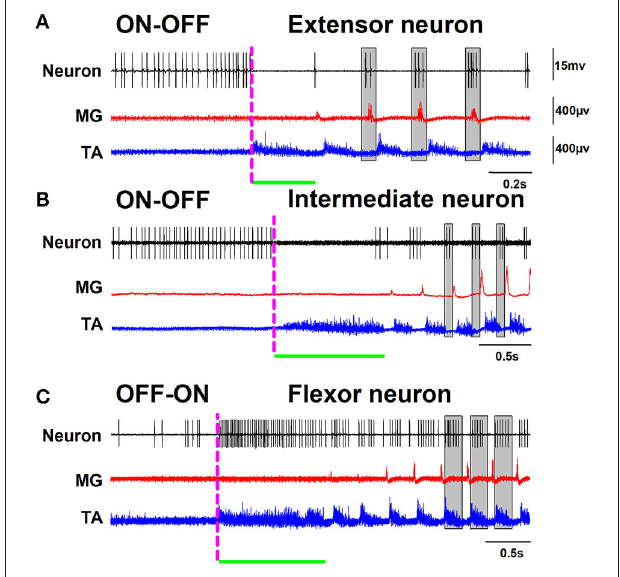
FIGURE 2 | The same as Figure 1 but on another timescale. The gray rectangles highlight in detail the phase relationship of the extensor, intermediate, and flexor neurons to the nerve